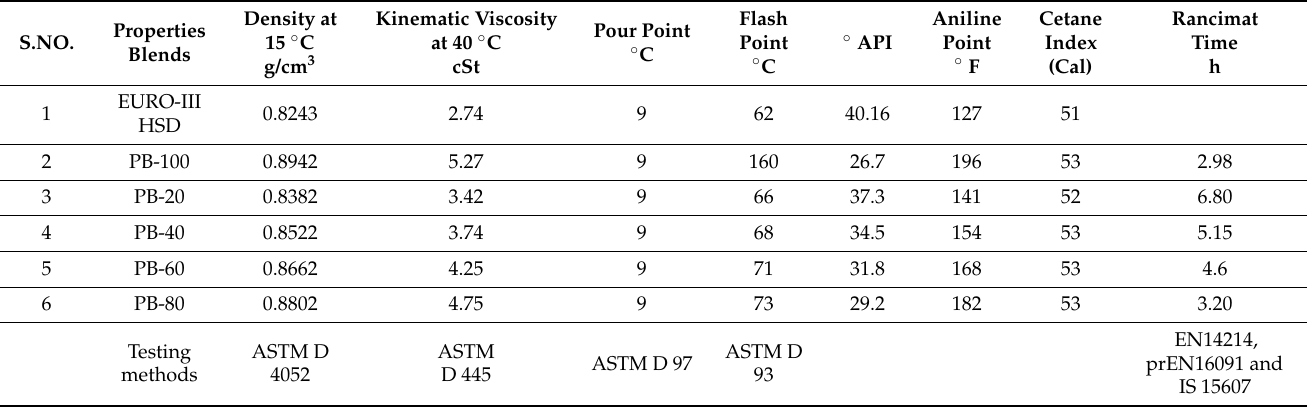
Table 7. Physical and chemical properties of EURO-III HSD and Pongamia pinnata methyl ester blends